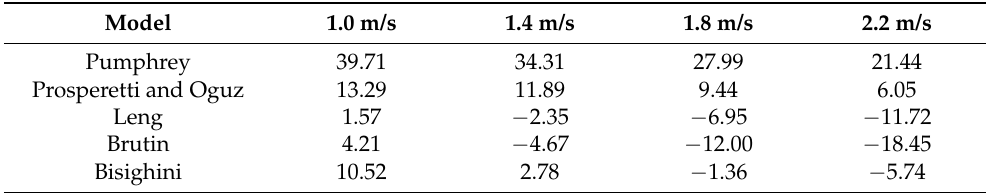
Table 4. Deviation between the maximum dimensionless crater depths predicted from the literature models and the median values of the quantity calculated from the simulations at the different velocities.